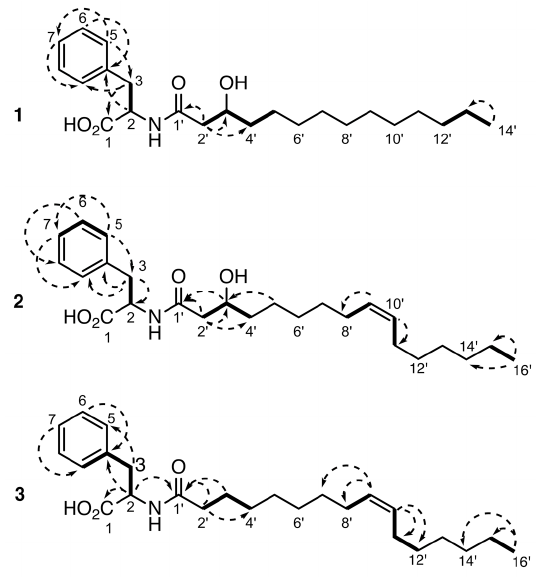
Figure 2. Key 1 H- 1 H COSY (bold lines) and HMBC (dashed arrows) correlations.